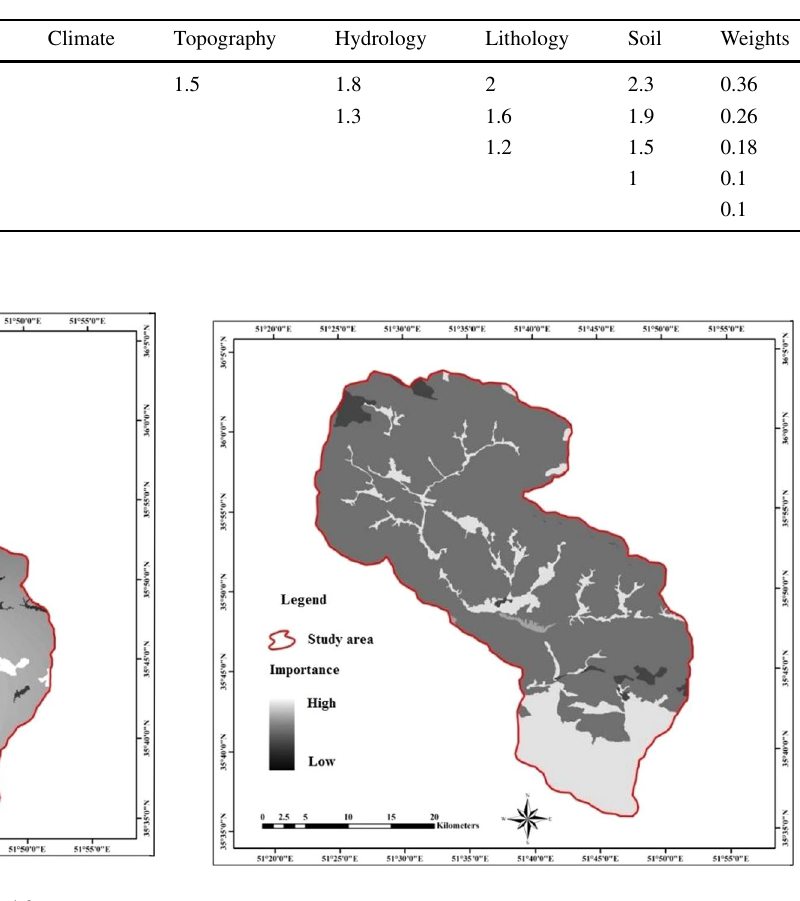
Fig. 2 Eco-hydrologic stability map of the social-economic-cultural factor